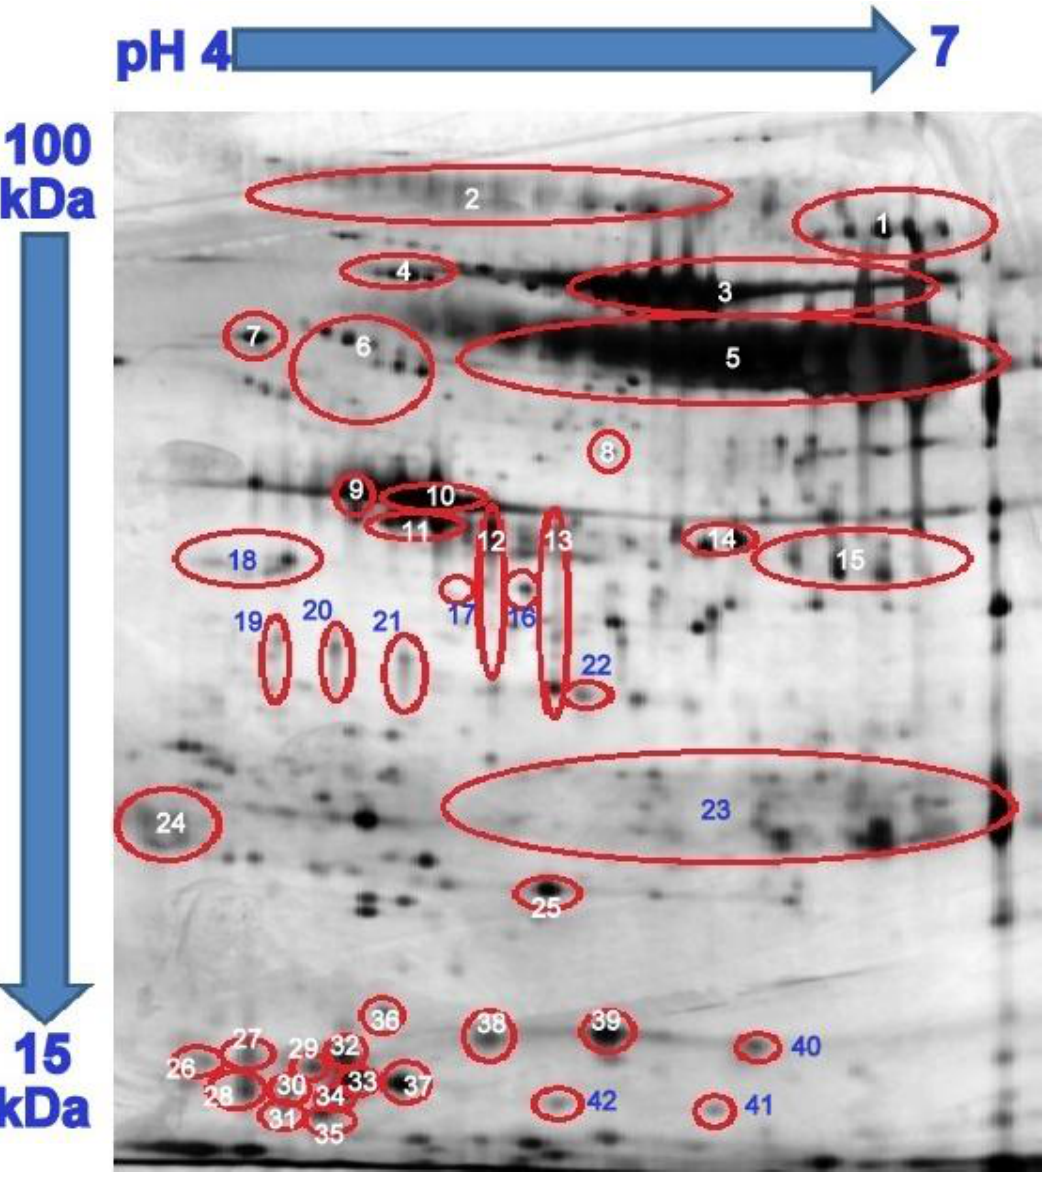
Figure 1. Typical 2-DE profile of human saliva protein. Comparisons were made with the one published by Jessie et al. [23] and the protein spots were suspected to be those as listed in Table